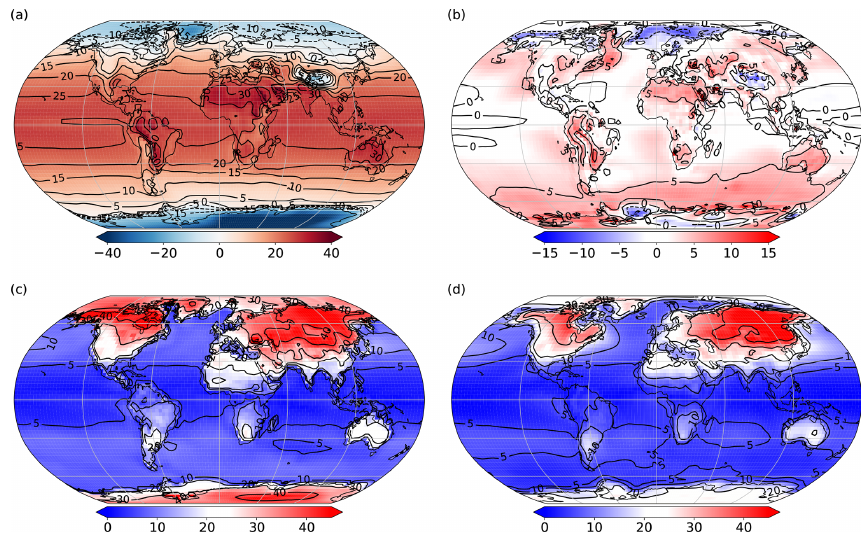
Figure 4. Time mean (years 2001–2025) plots from the L35 configuration showing surface air temperature ( ◦ C): (a) annual mean,